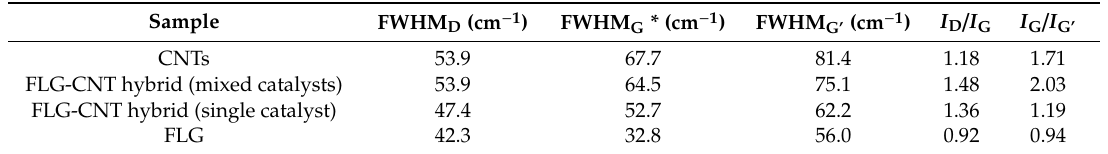
Figure 2. Raman spectra at room temperature of CNTs, FLG, and FLG-CNT hybrids produced from single and mixed catalysts ( λ exc = 532 nm). Table 1. Full width at half maximum (FWHM) for D, G and G’ bands, and I D / I G and I G / I G’ ratios